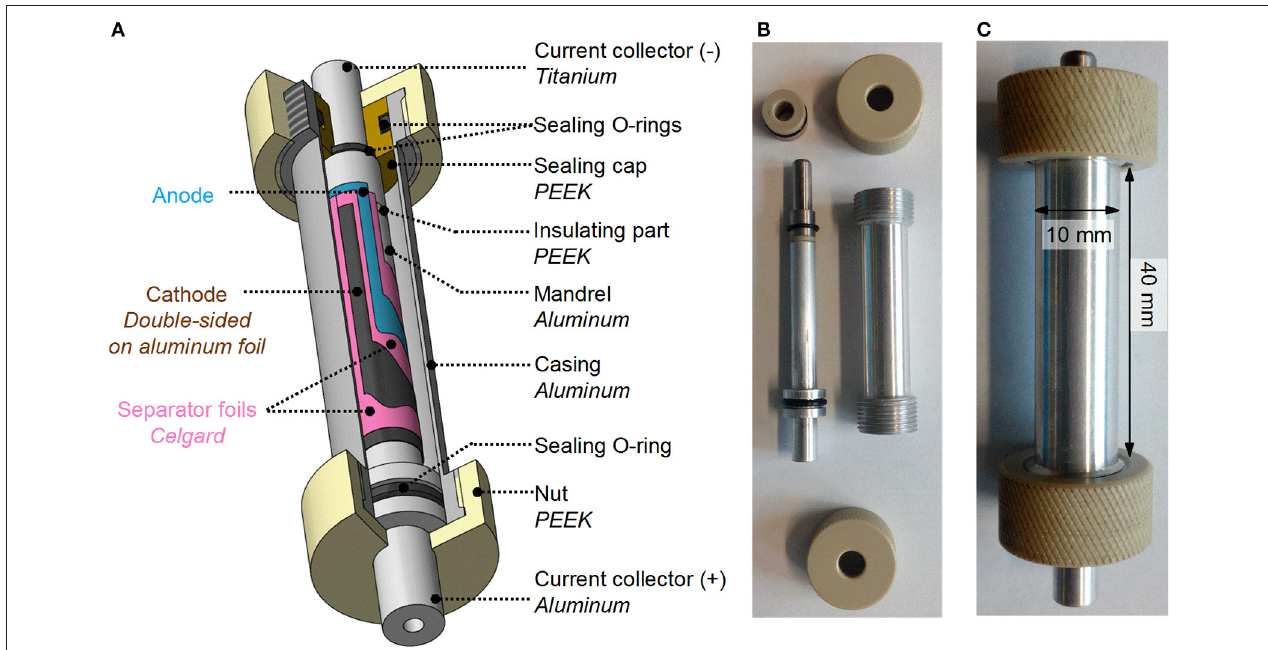
FIGURE 2 | (A) Neutron diffraction patterns of all components of the cylindrical cell (other than cathode and anode). (B) Neutron diffraction patterns of several dry polymeric foils as a possible separator. The intensities are normalized for two separator foils used in the cylindrical cell.